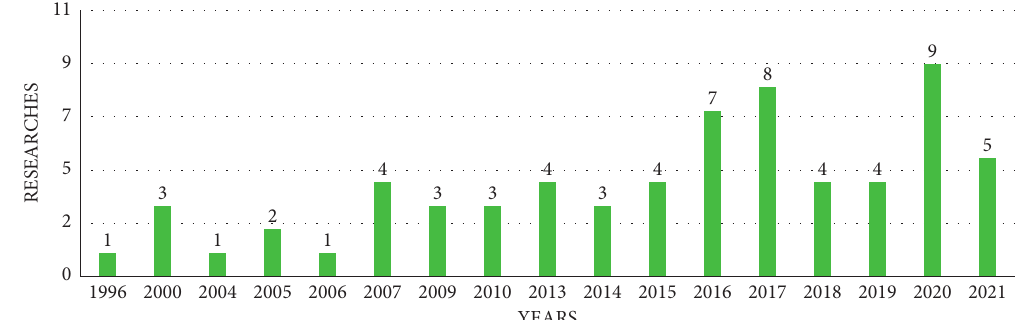
Figure 5: Frequency of investigations through the